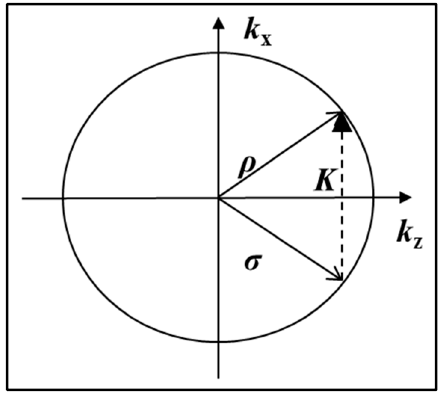
Figure 9. Ewald diagram of an unslanted transmission grating replayed the on-Bragg angle, σ = ρ − K . k x and k z are the x and z phase space axes.